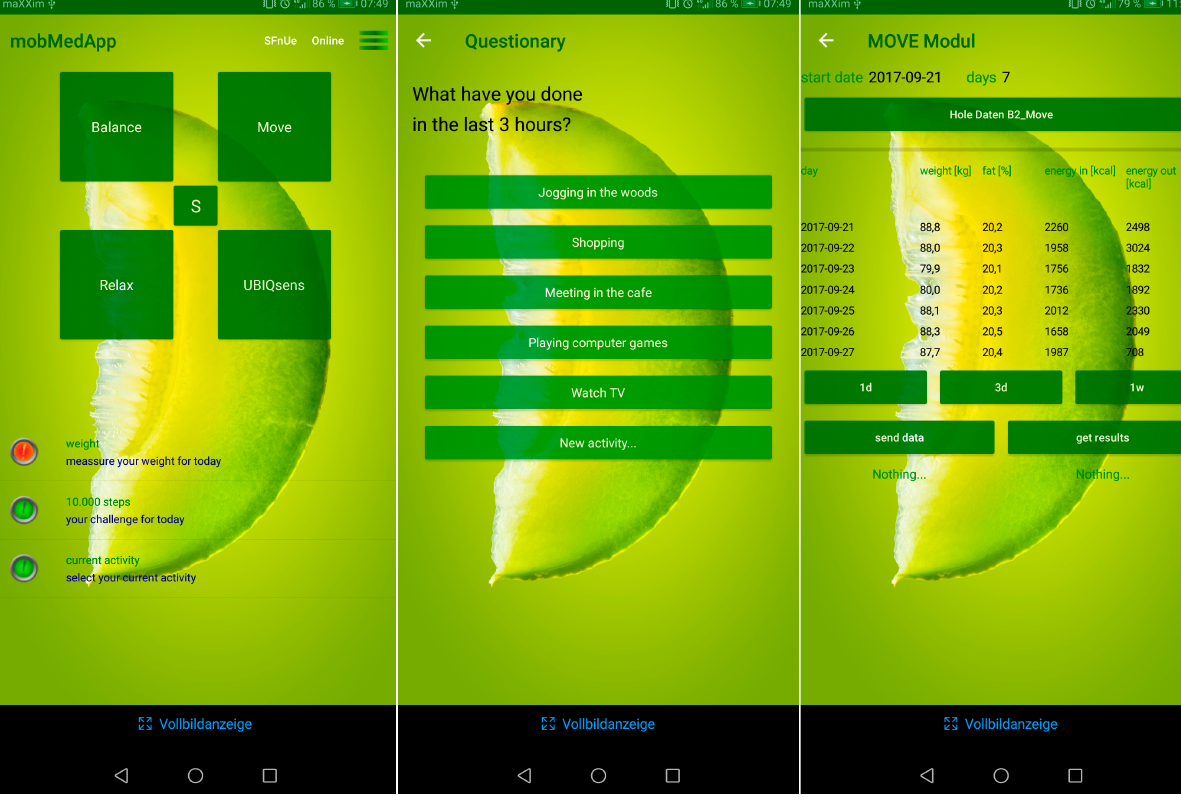
Figure 6: Graphical user interface (GUI) of the MobMedApp ; left: main screen with supported investigation categories and listed intervention tasks; middle: questionnaire for individual acquisition of objective/subjective information; right: conclusion of acquired data for current investigation